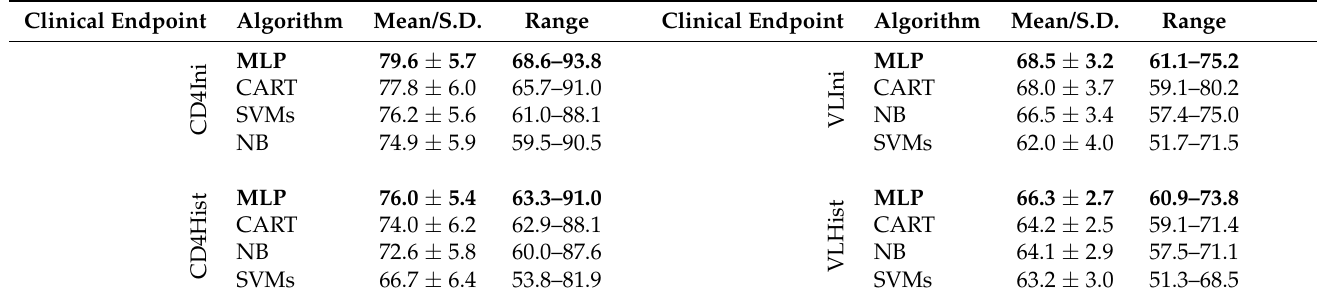
Table 1. Summary of the performance of the algorithm considering 100 runs on the balanced datasets for each clinical endpoint in descending order of their mean value. Our results demonstrate that MLP produced the best classification performance for all the comparisons made.